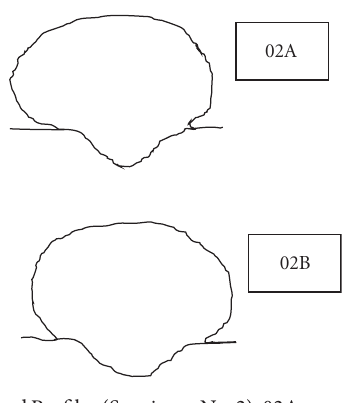
Figure4:TracedProfiles(SpecimenNo.2).02Arepresentsprofileof the specimen (front side) and 02B represents profile of the specimen (rear side). The measured clad bead dimension and percentage of dilution is shown in Table